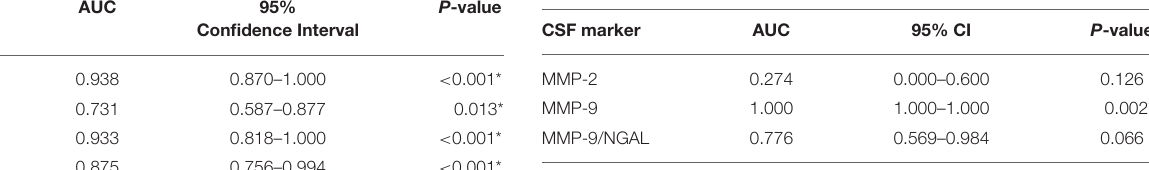
TABLE 3 | ROC analysis of markers in cerebral spinal fluid for differentiating patients with moyamoya disease from